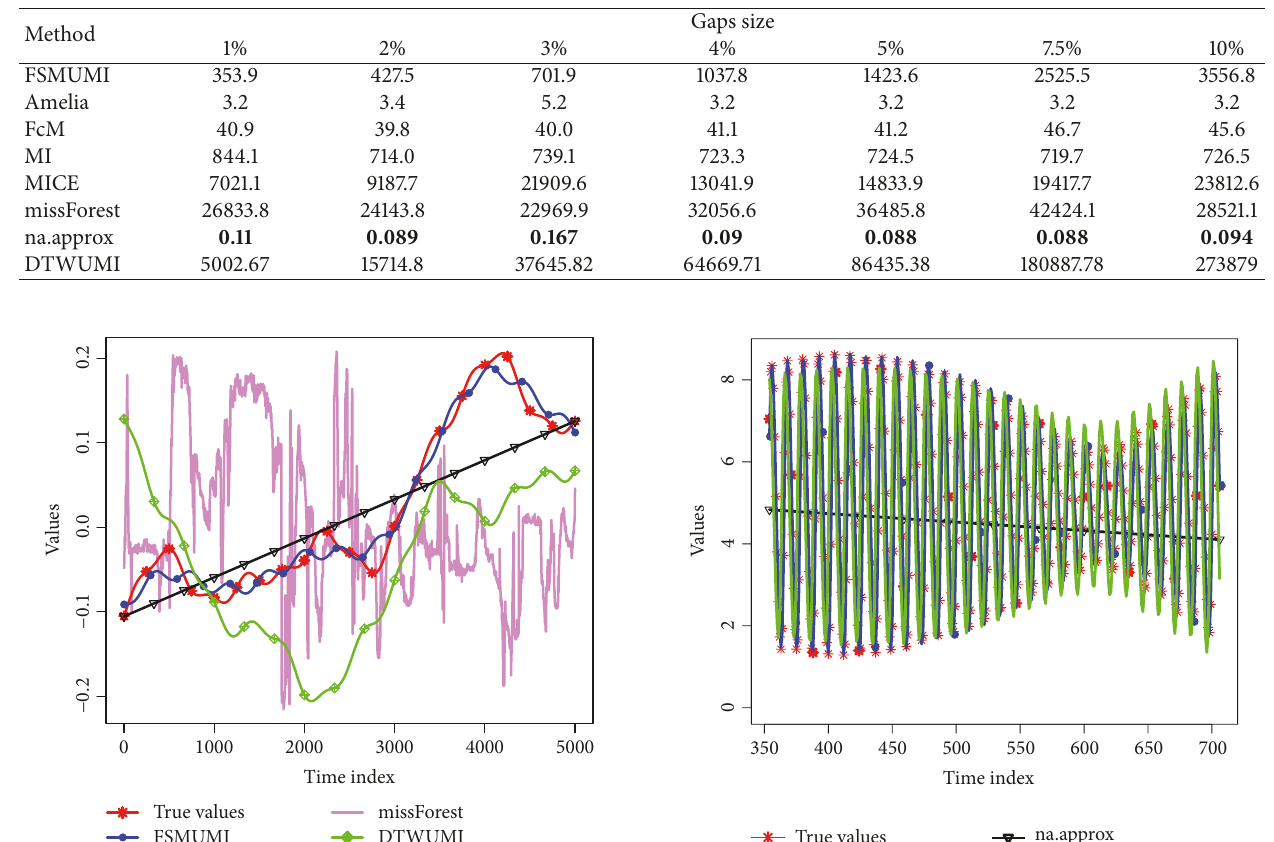
Table 4: Computational time of different methods on the synthetic series in second (s).